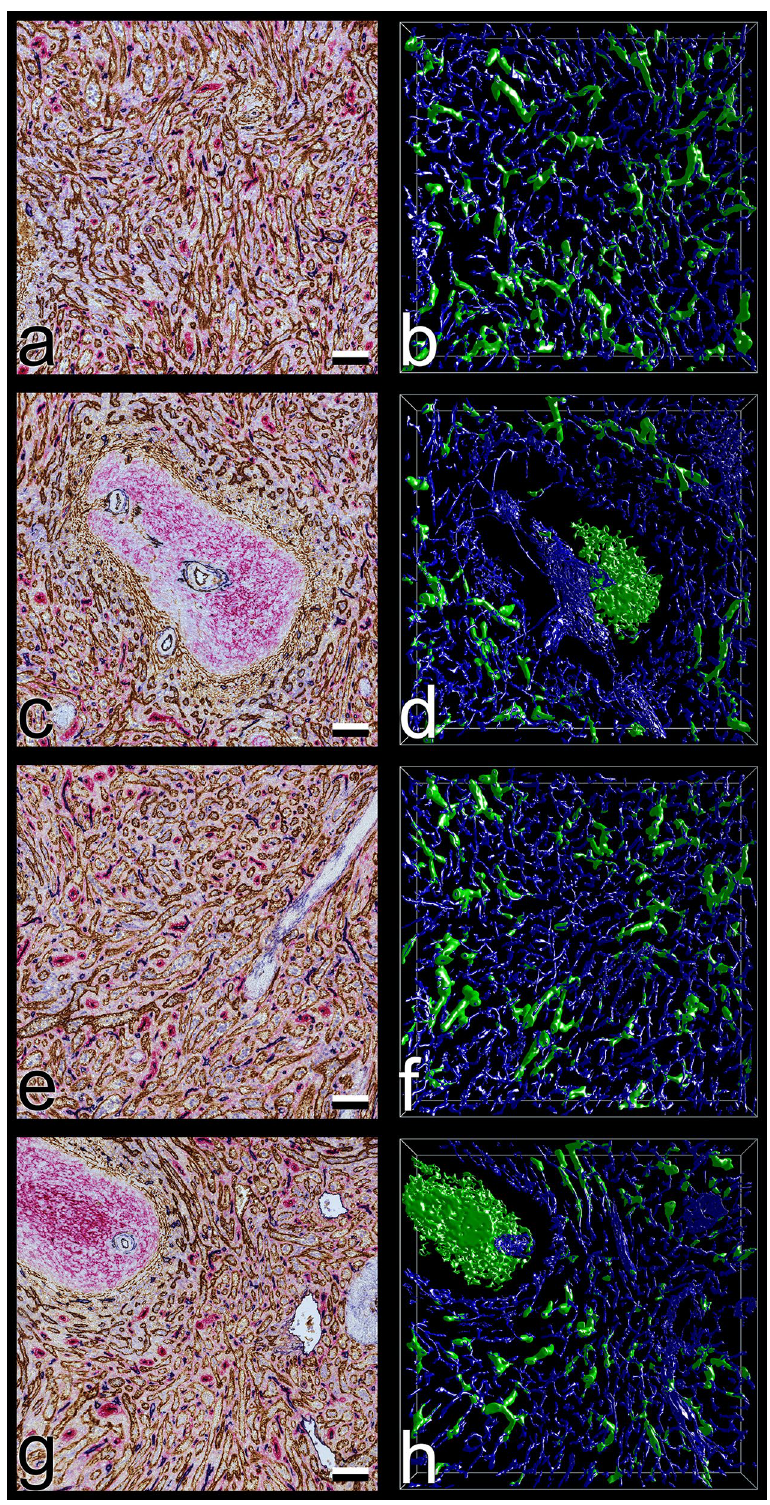
Figure 3. Section No. 21 (left) and 3D models of ROI 1–4 (right). ( a , b ) ROI 1, ( c , d ) ROI 2, ( e , f ) ROI 3, ( g , h ) ROI 4. The 3D models visualize staining for CD34 (blue: endothelia) and CD271 (green: stromal capillary sheath cells and FDCs). ROI 2 and ROI 4 contain white pulp with a follicle. The models were designed to represent only CD34 ++ and CD271 ++ cells by adjustment of iso-values. Granular blue staining at the surface of follicles represents residual CD34 in sinus endothelia. Scale bars in ( a , c , e , g ) = 100 µm. Sides of bounding box in ( b , d , f , h ) = 1